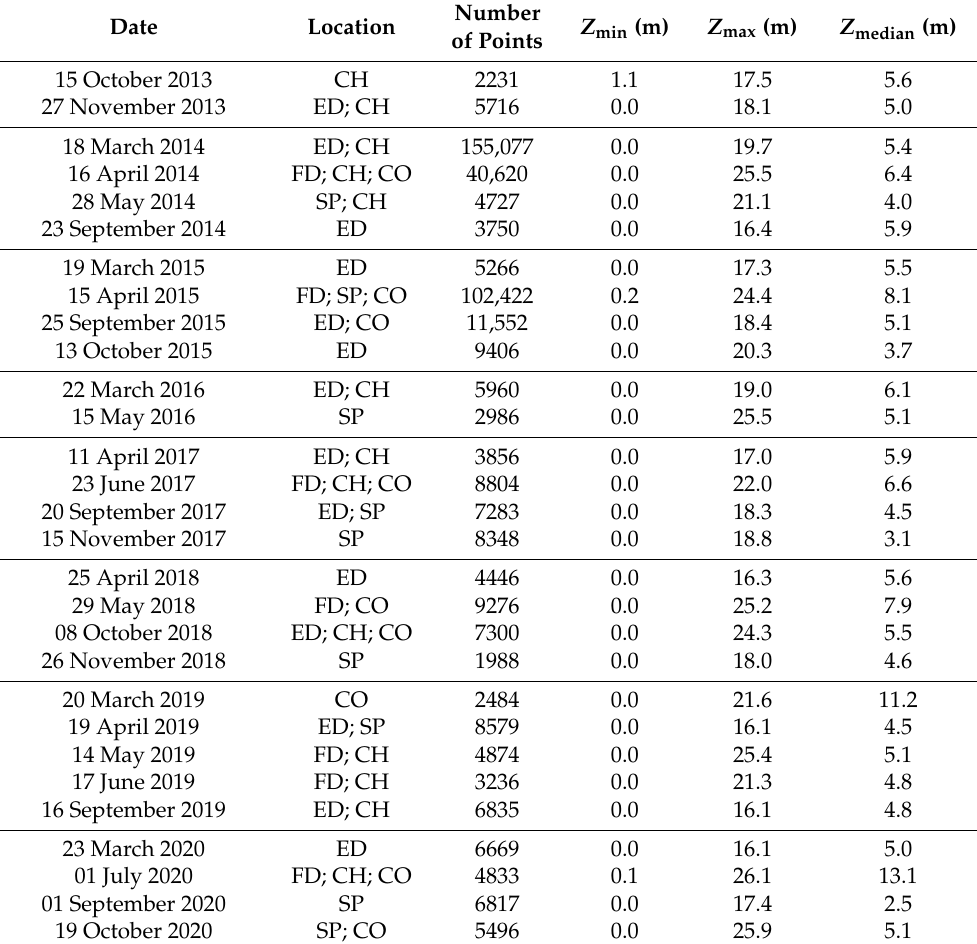
Table 1. Date, location (ED: Ebb tidal Delta; FD: Flood tidal Delta; SP: Cap Ferret sand Spit Platform; CO: Coastal Ocean; CH: Channel), number of echo sound data points, and the minimum, maximum and median values of Z situ , associated with the different bathymetric